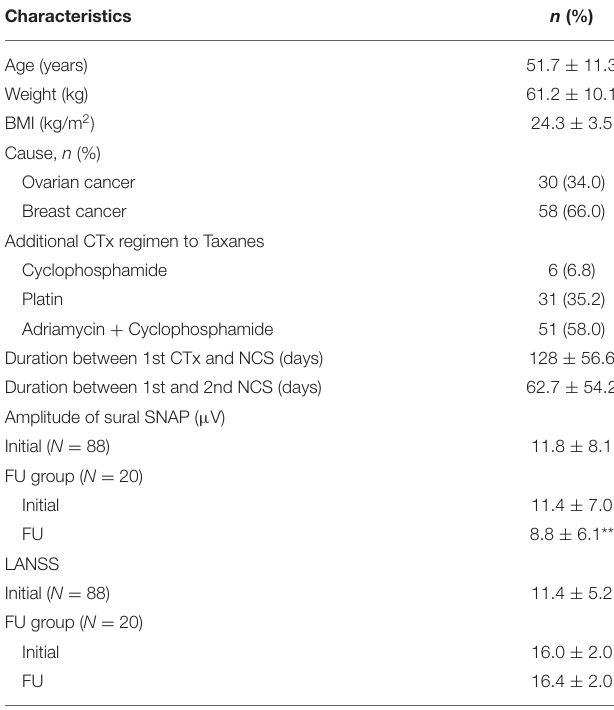
TABLE 1 | Demographic and clinical characteristics ( n =